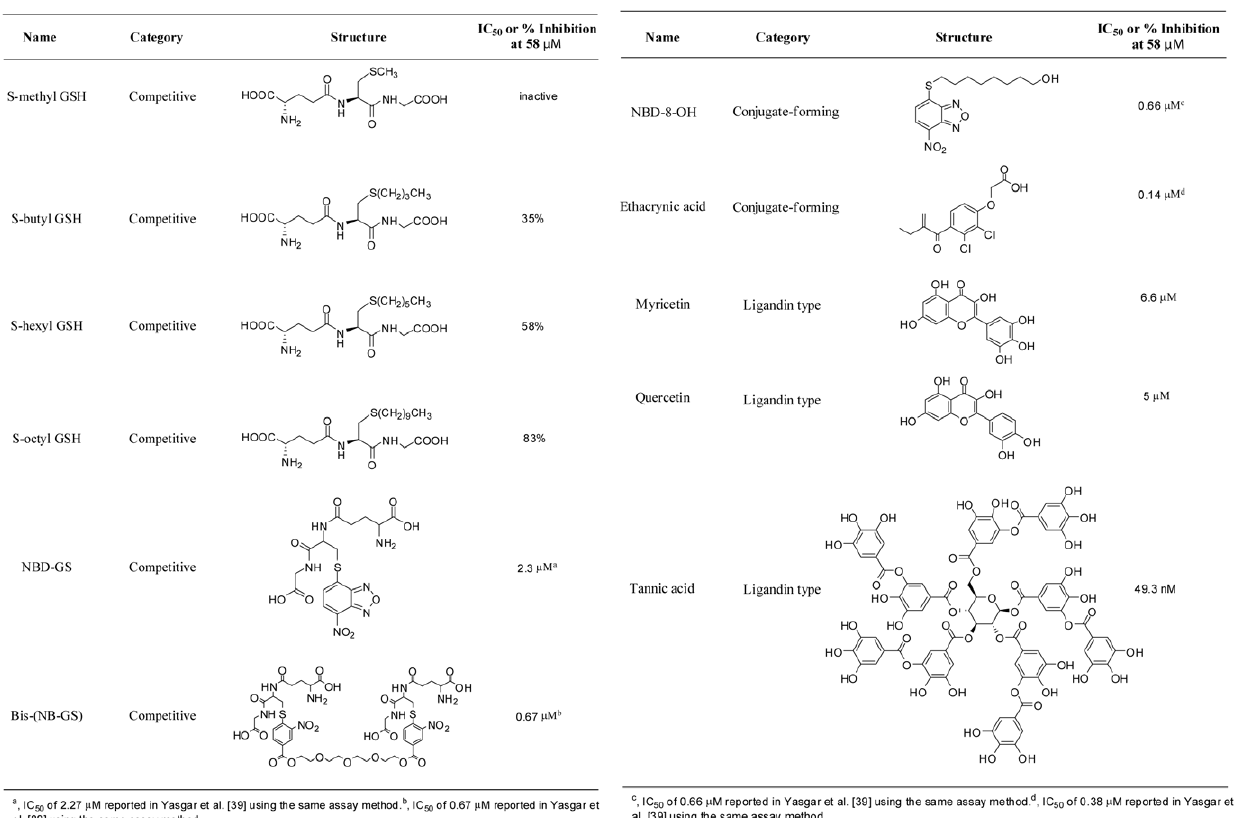
Figure 1. GST inhibitors tested in this study and their inhibitory activity against Sj GST.